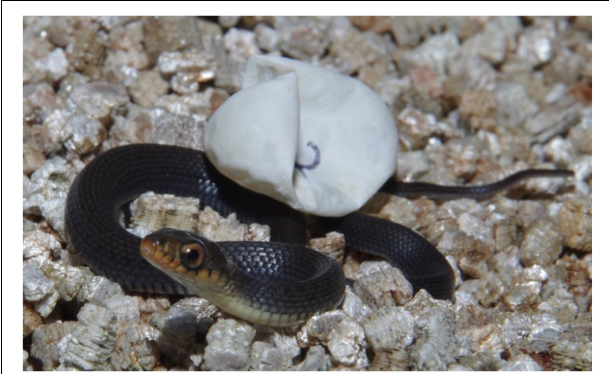
FIGURE 1 | Recently emerged hatchling keelback, Tropidonophis mairii . Photograph by G. P.